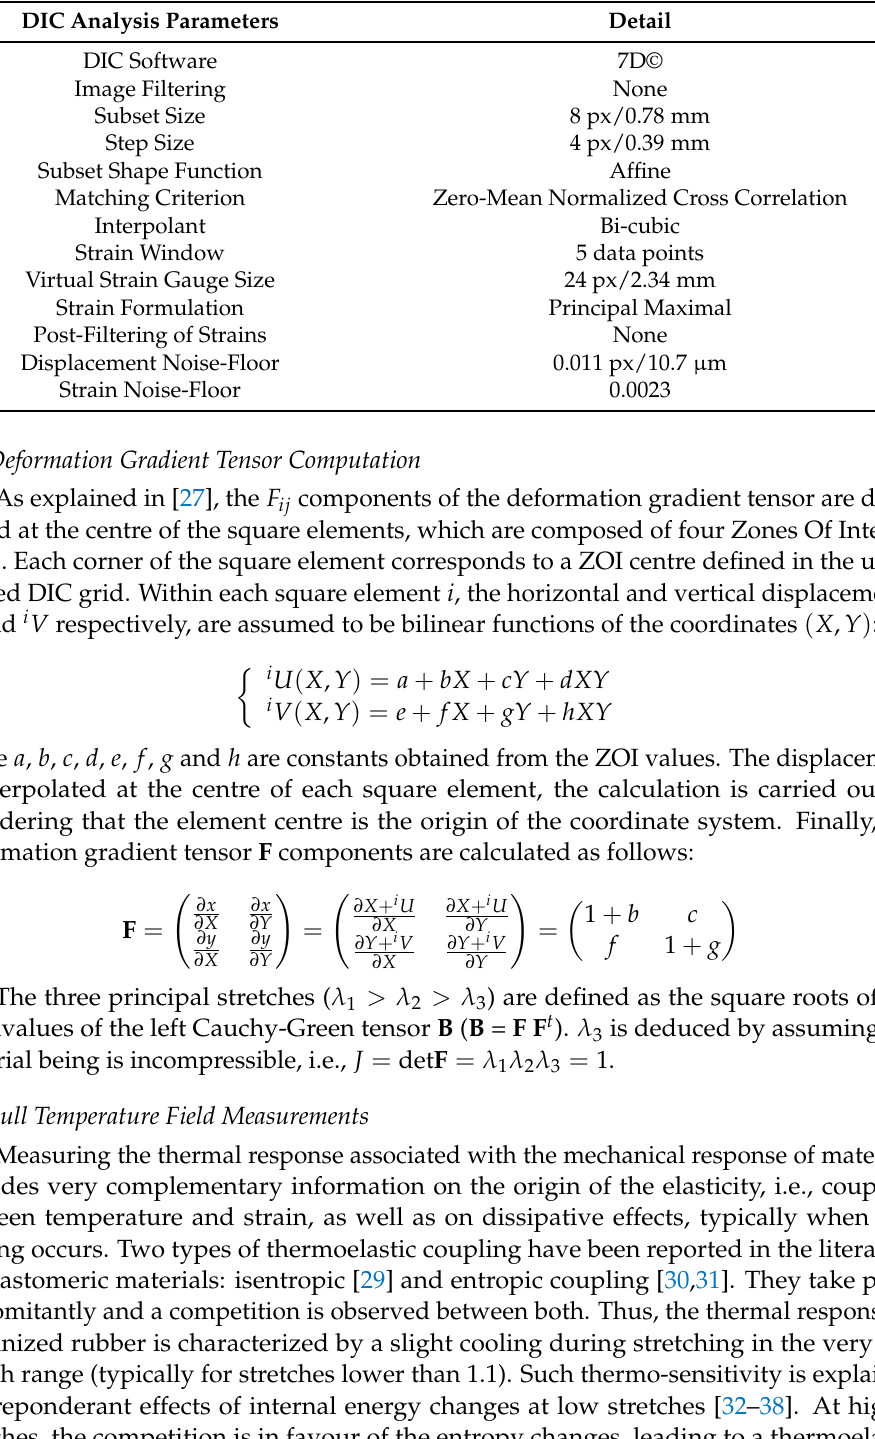
Table 4. DIC Software